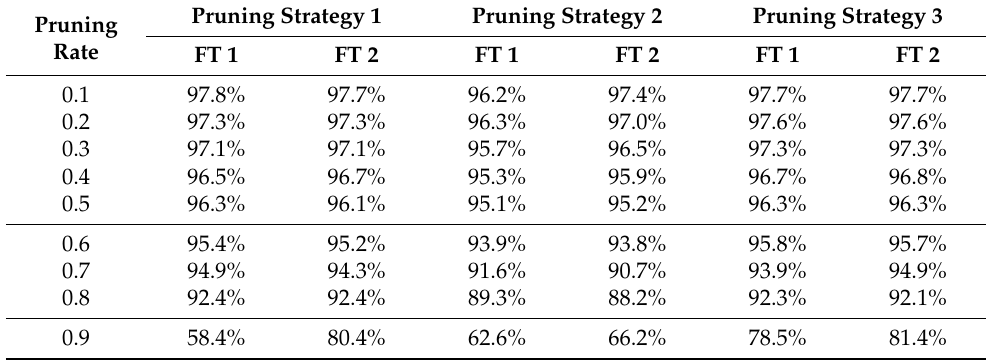
Table 4. The effect of different fine-tuning methods on the recovery of prediction